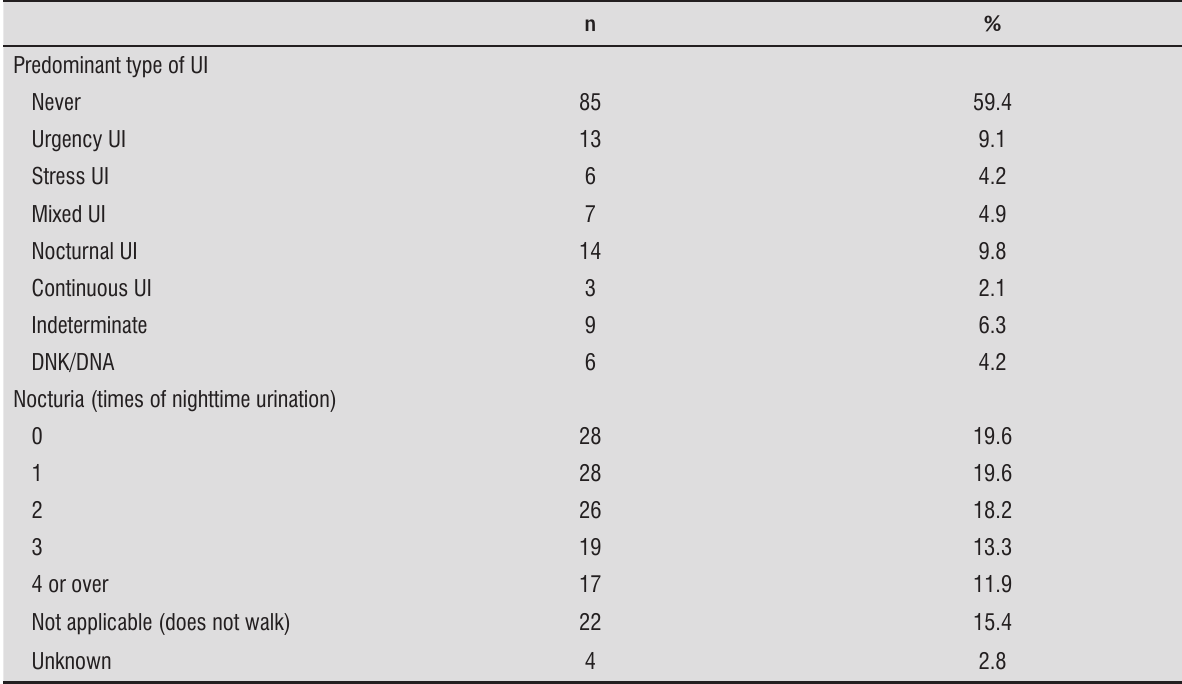
Table 2 - UI characteristics, according to ICIQ-SF, as well as nocturia – Natal (RN), 2014